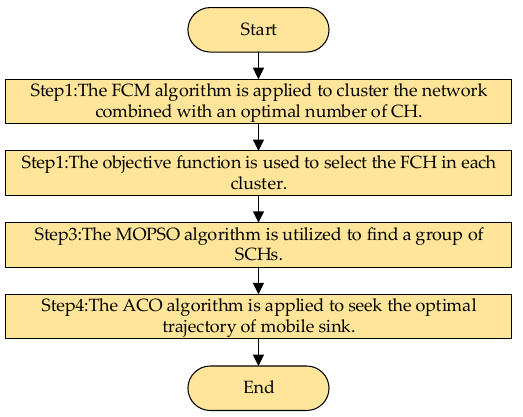
Figure 3. The schematic diagram of the proposed approach.